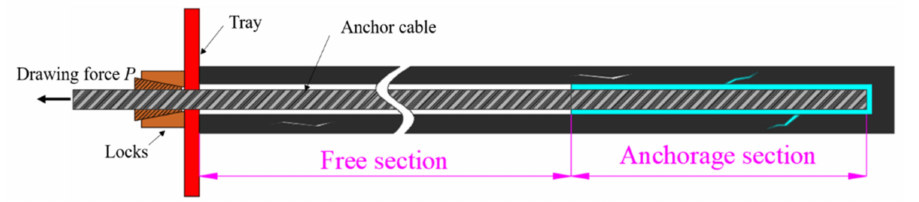
Figure 17. Schematic diagram of the anchor cable in the